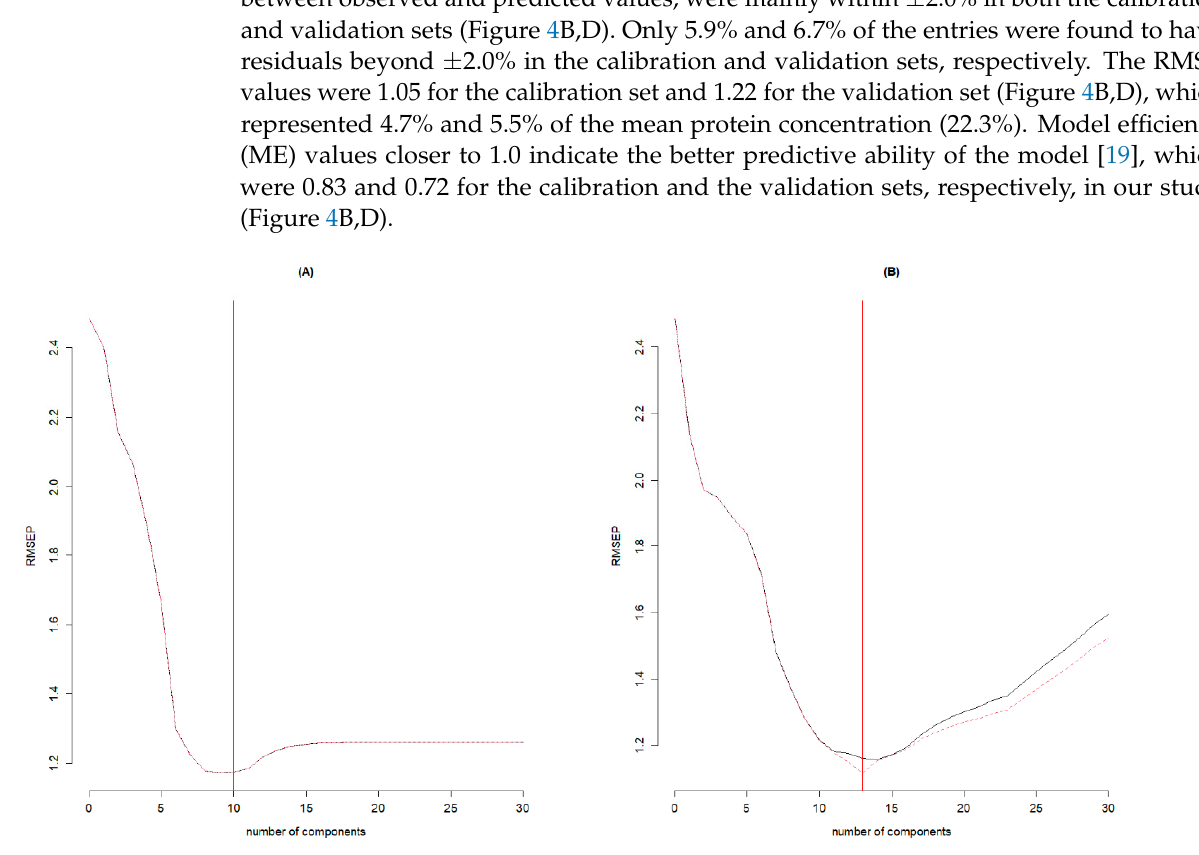
Figure 4. Different plots for partial least square regression (PLSR) using DA7250 spectral data: ( A ) scatter plot of predicted values against observed values for the calibration set, ( B ) plot of residual values against predicted values for the calibration set, ( C ) scatter plot of predicted values against observed values for the validation set, and ( D ) plot of residual values against predicted values for the validation set.